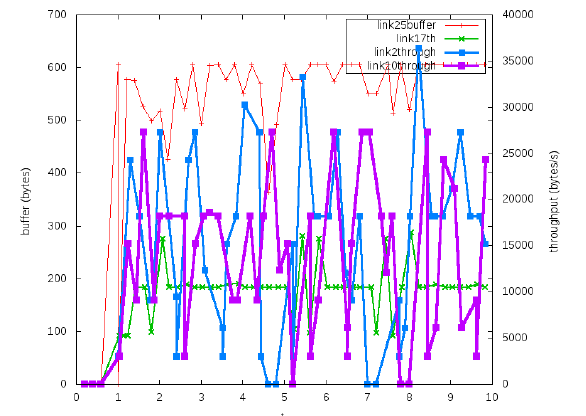
Fig. 5. Aggregate good traffic and aggregate bad traffic, as measured at the sources, when the firewall is not active